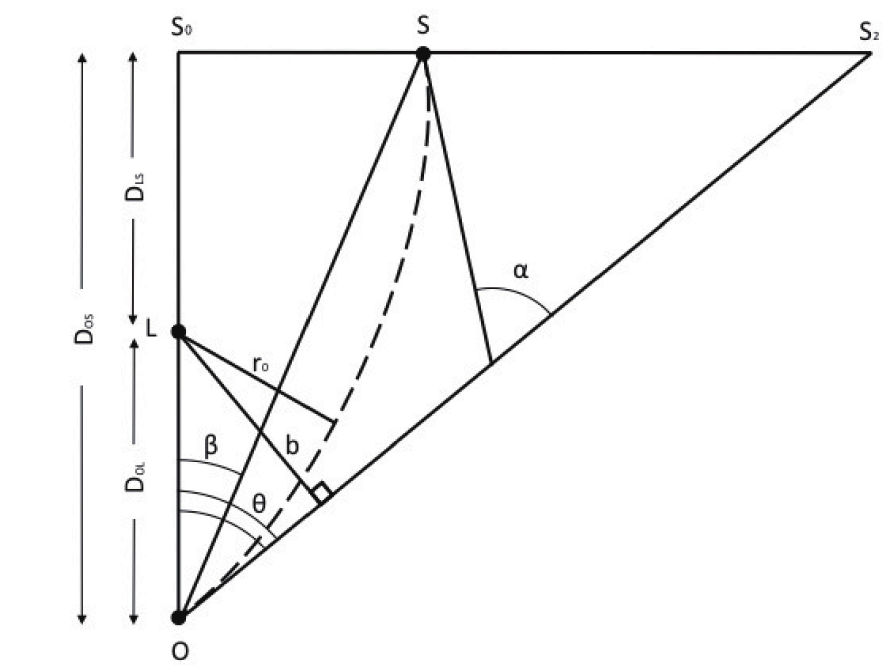
Figure 11. The gravitational lensing geometric for a point-like source lens L at distance D from observer O . A source S at distance D from O has angular position β from the lens. OS A light ray (dashed line) from S which passes the lens at minimal distance r by α ; the observer sees an image of the source at angular position θ = b/D the impact factor. D is the distance LS